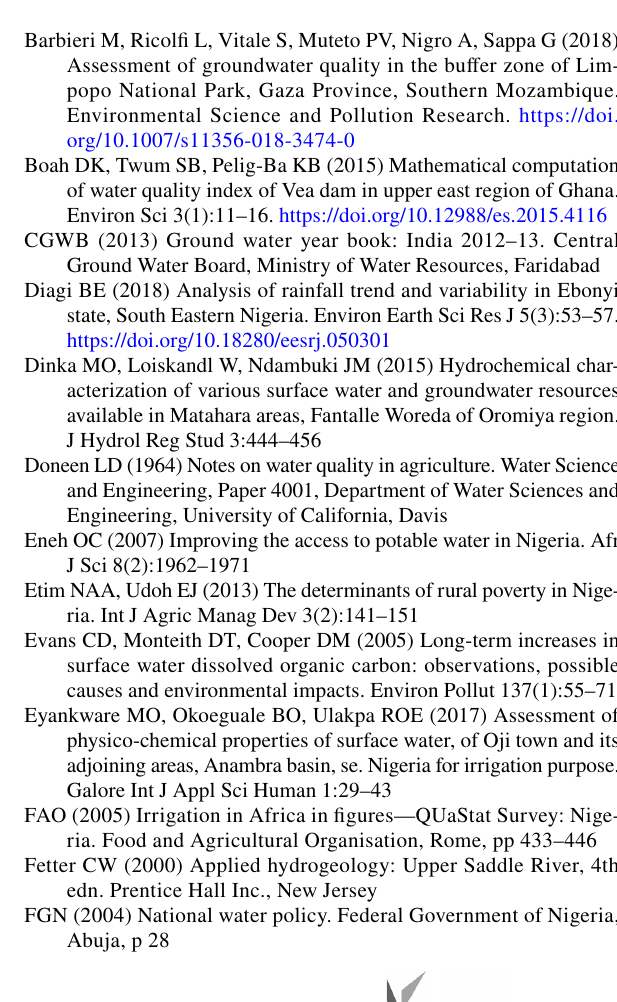
Fig. 17 River Mamu basin water sample plot on the Piper